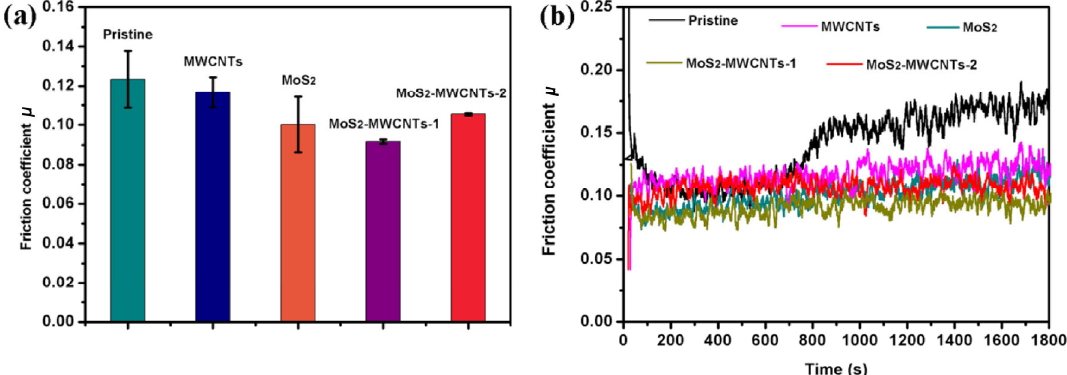
Fig. 6 (a) Average friction coefficients and (b) evolutions of the friction coefficients with time for the different filler reinforced polyurethane composite